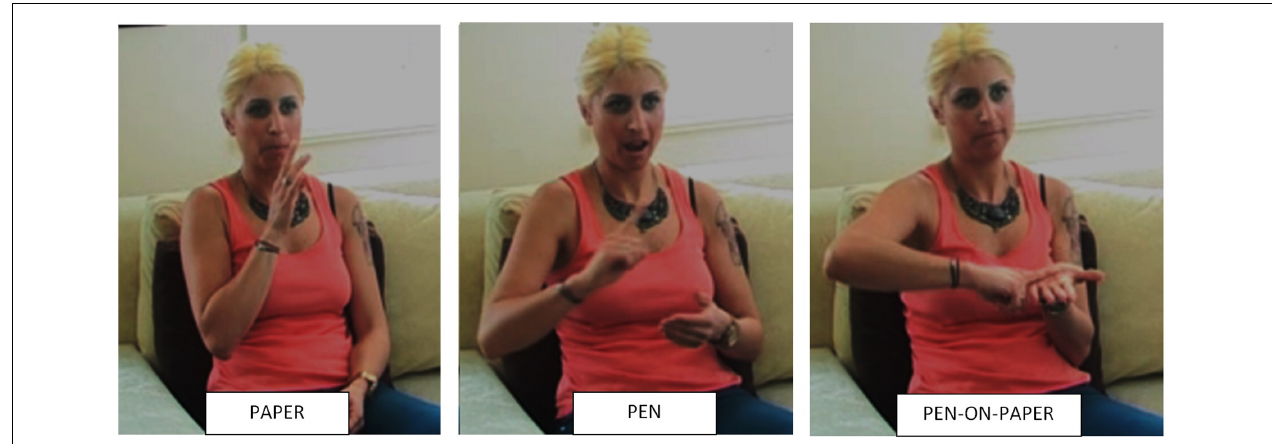
FIGURE 5 | Classifier construction in Turkish Sign Language ( Turk Isaret Dili, T˙ID). The lexical signs PAPER (ground) and PEN (figure) precede the structure PEN-ON-PAPER which represents iconically the spatial relationship between both objects.